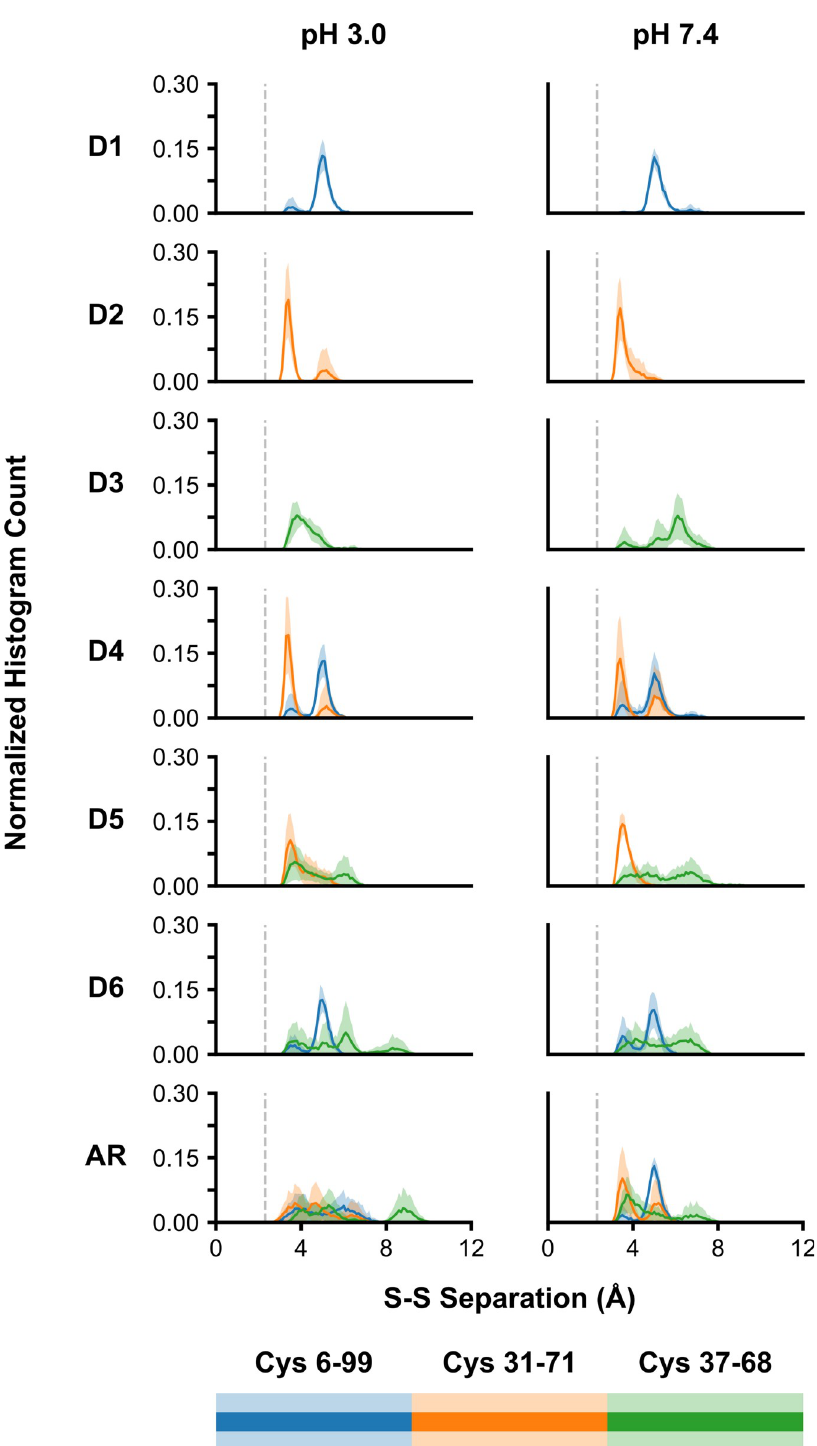
Fig 2. Separation between native cysteine sulfur atom pairs after disulfide reduction at pH 3.0 and pH 7.4. The native cysteine sulfur atom pairs were Cys6-Cys99 (blue), Cys31-Cys71 (orange), and Cys37-68 (green). Data were presented as a histogram over the last 10% of the simulations for each monomer and replicate. Dark lines are the average per-bin across the replicates and monomeric units ( n = 6). Lighter shaded regions correspond to the per-bin standard deviation. The grey dashed line indicates the S-S distance in an intact disulfide bond (0.2038 nm).